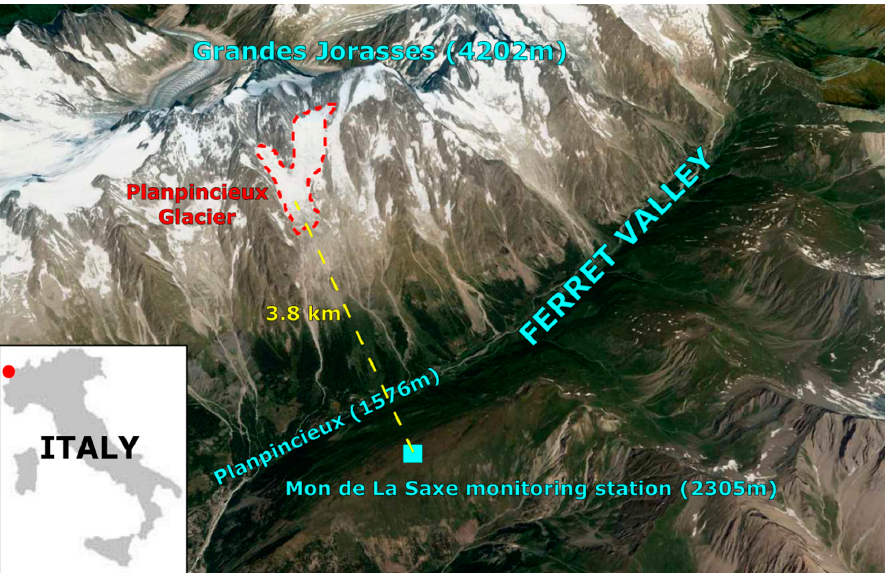
Figure 1. Aerial view of the Ferret Valley. The Planpicieux glacier is located in the upper part of the image. In the bottom part of the Ferret Valley, the Planpincieux hamlet represents the main element at risk of possible ice avalanche activation. On the opposite side of the valley, at a distance of 3.8 km, the monitoring station is located on the top of Mon de La Saxe.